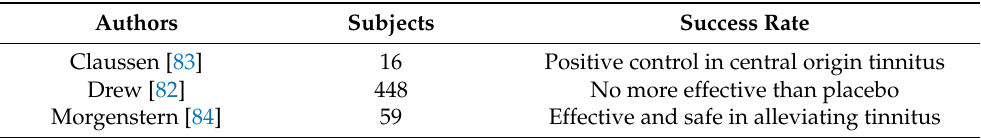
Table 10. Summary of studies that used ginkgo biloba to treat tinnitus.